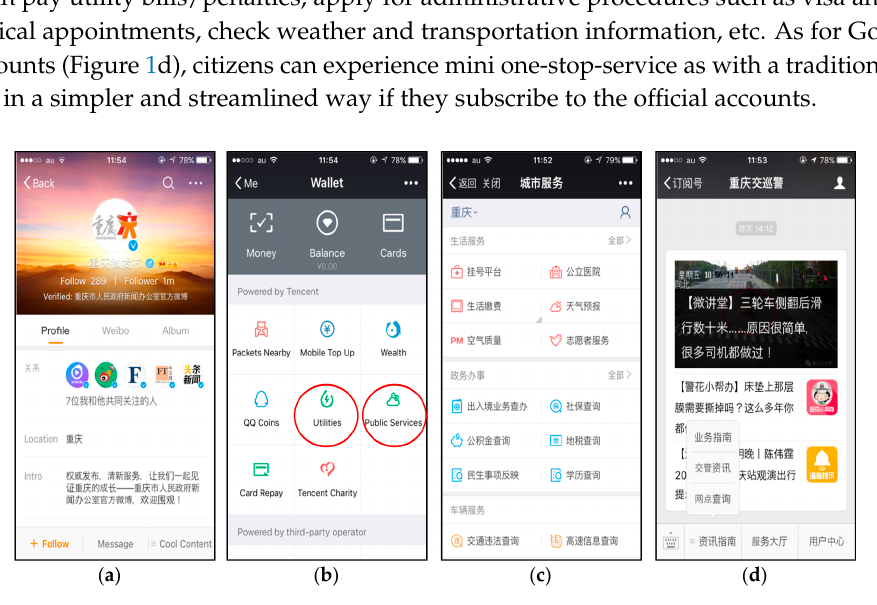
Figure 1. Interfaces of Weibo and WeChat governmental e-services (mobile version): ( a ) interface of Weibo account “Chongqing weifabu” created by Chongqing government press office; ( b ) Public city- service platform embedded in “wallet” function of WeChat application; ( c ) Interface of public city-service platform on WeChat; ( d ) Interface of government official account on